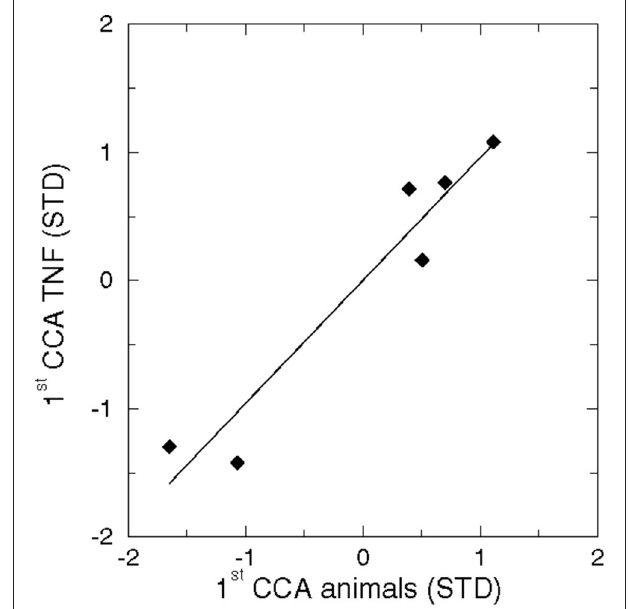
FIGURE 9 | Correlation between the 1st CCA pattern of benthic animals and the 1st CCA pattern of TNFs ( r = 0.96, n = 6, p < 0.01).